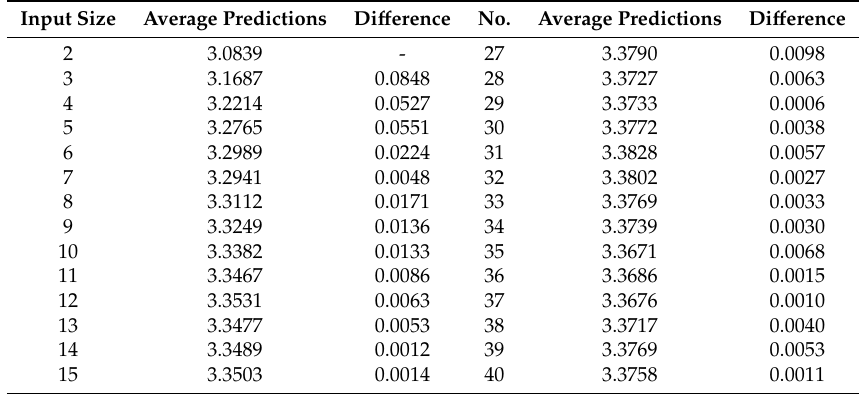
Table 7. Changing average of prediction and difference for each range (the item-based filtering: the Pearson correlation coefficient).